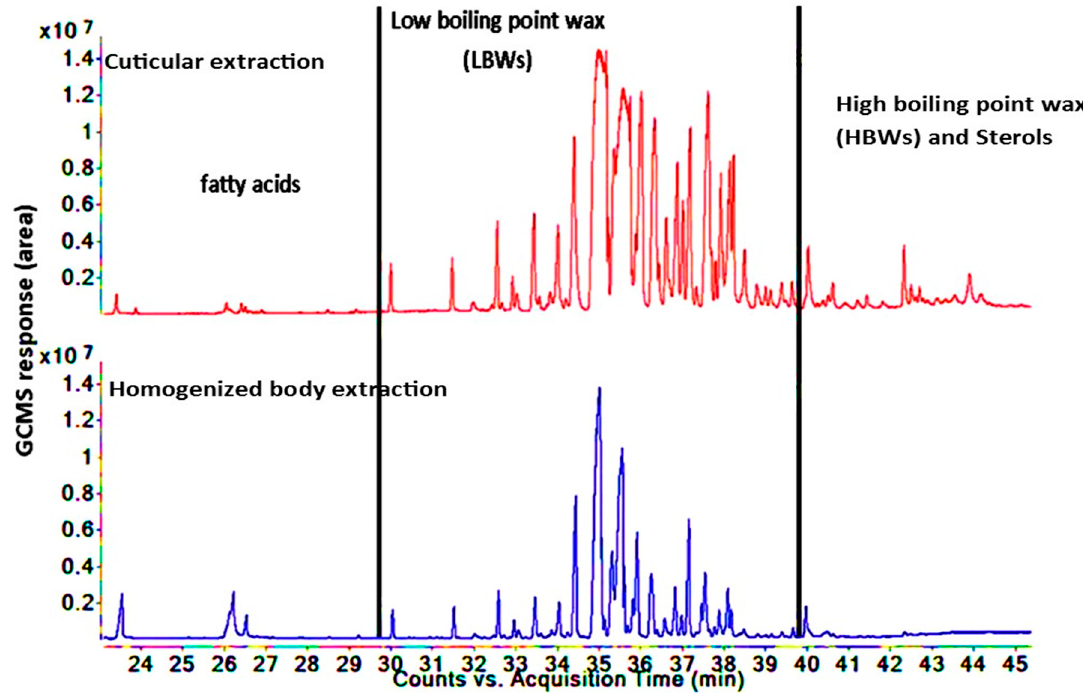
Figure 1. Total signal chromatogram of lipids of cuticular extraction followed by homogenized body extraction of same insects of Tribolium castaneum, using acetonitrile as solvent.